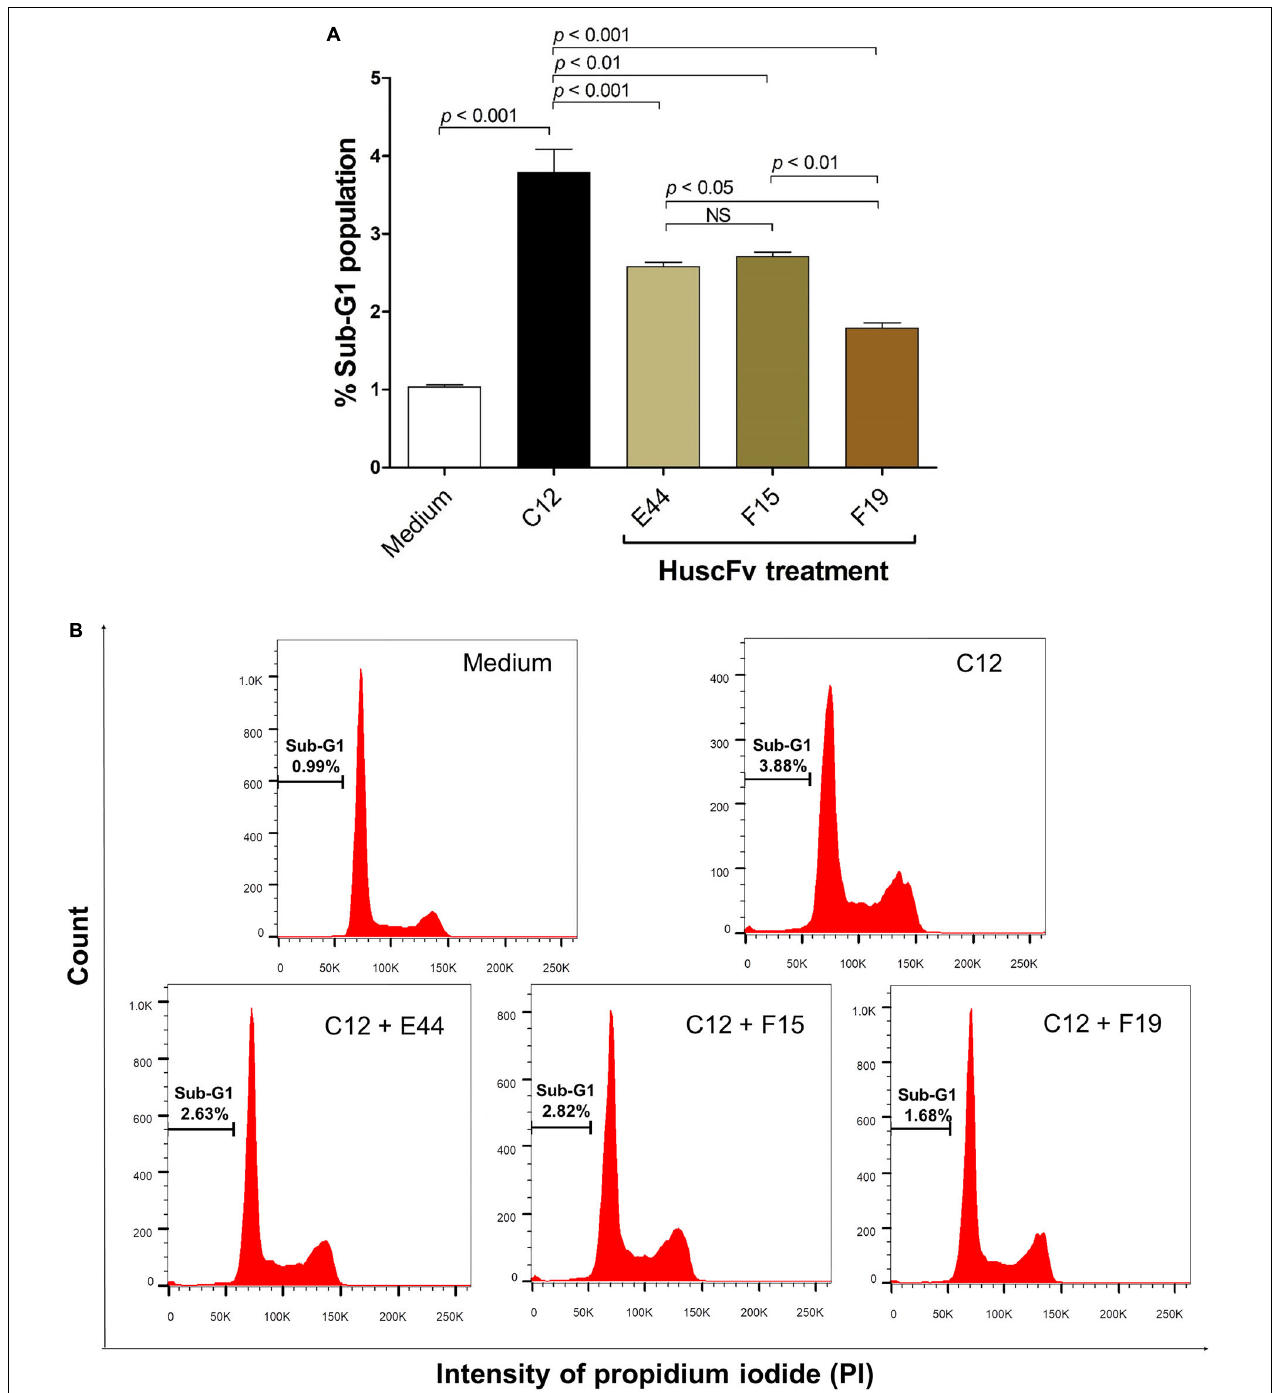
FIGURE 6 | Reduction of sub-G1 arrest population of 3O-C12-HSL-exposed cells by HuscFvs. (A) Percent sub-G1 population (mean ± SD of triplicate individual experiments) after different treatments. (B) Histograms of cell cycle distribution. The percentage of apoptotic cells in the hypodiploid DNA peak (sub-G1 population) of each treatment is indicated in each plot.